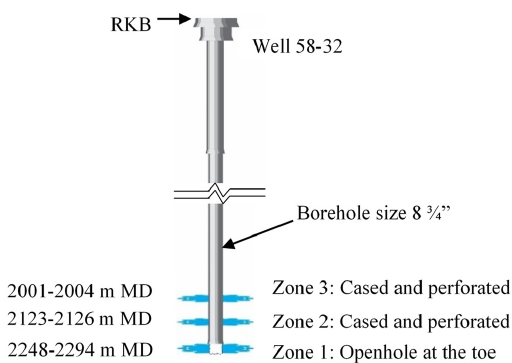
Figure 4. Injection testing zones of Well 58-32. Zones 1 and 2 were stimulated with hydraulic fracturing, including pump-in / shut-in and pump-in / flowback tests. Attempts were made to stimulate Zone 3, but the stimulation was not successful and is not discussed in this paper. The basic principles of isolation and pumping are well-described in [2]. Energies 2020 , 13 , x FOR PEER REVIEW